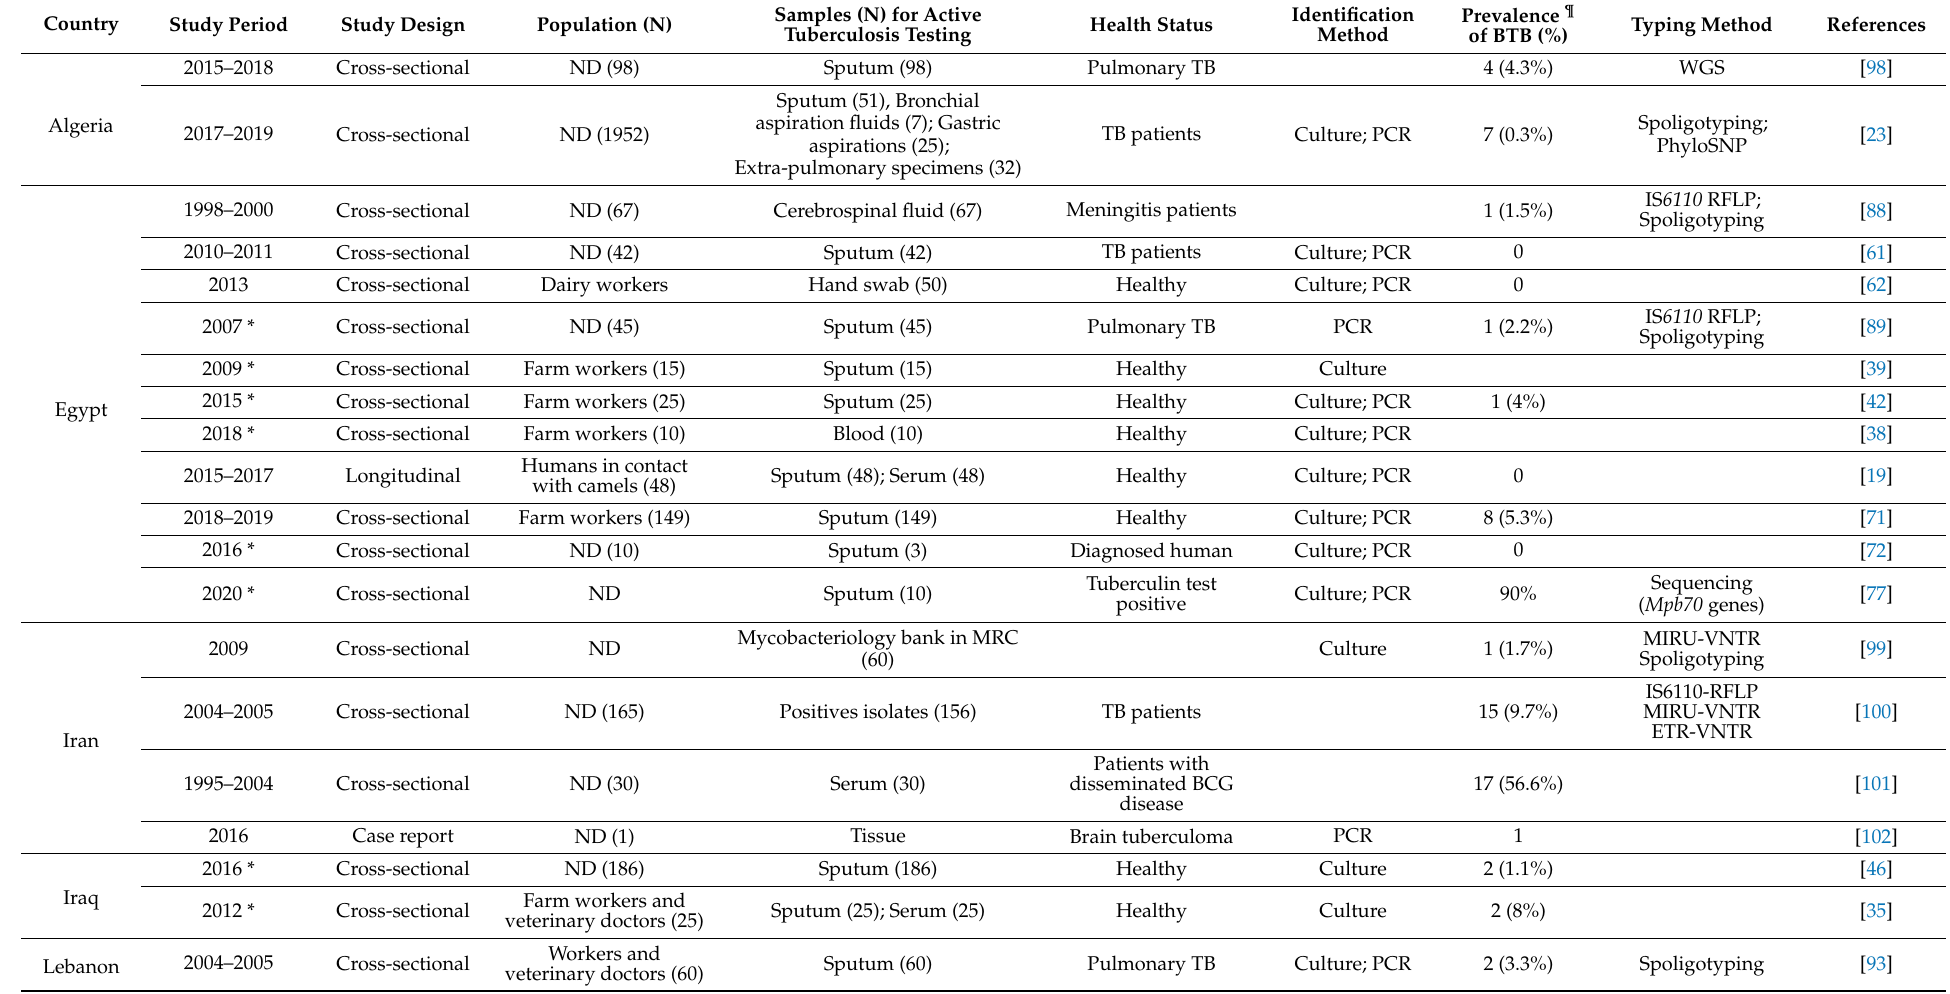
Table 2. Burden of Mycobacterium bovis among humans in the MENA